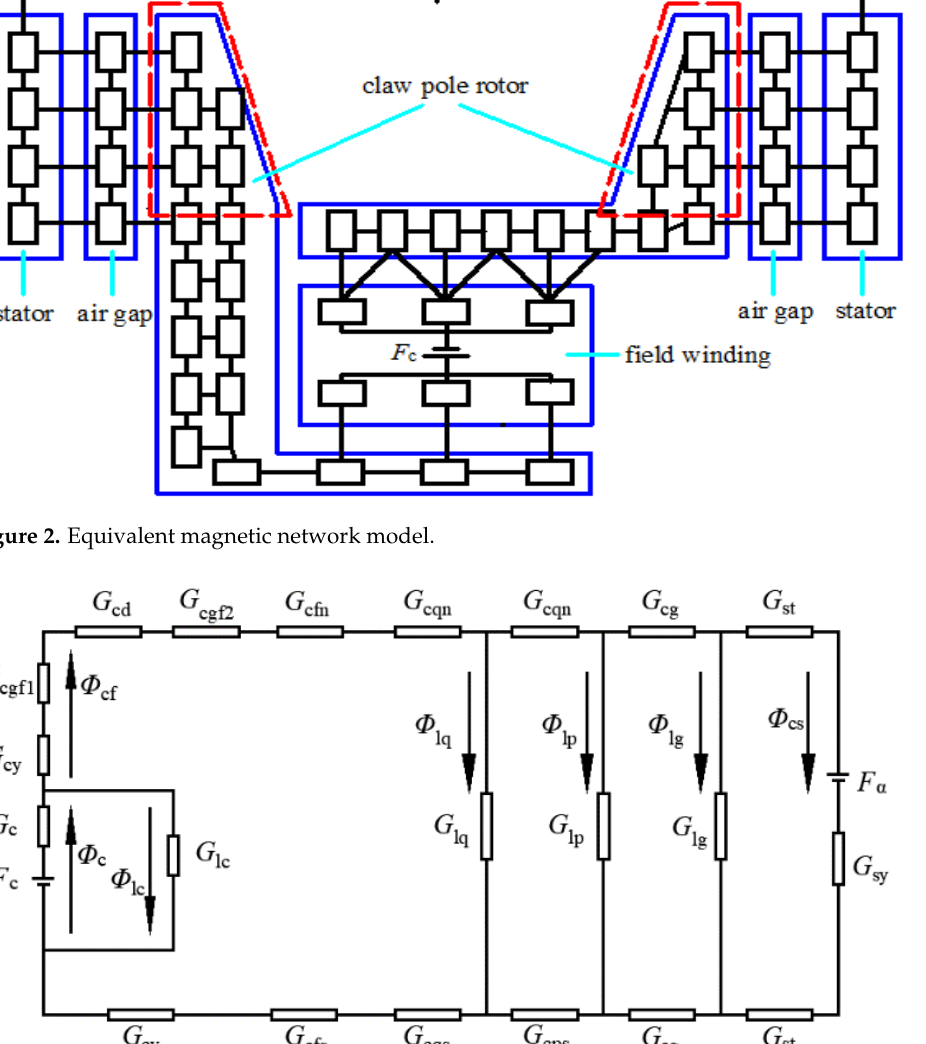
Figure 2. Equivalent magnetic network model.